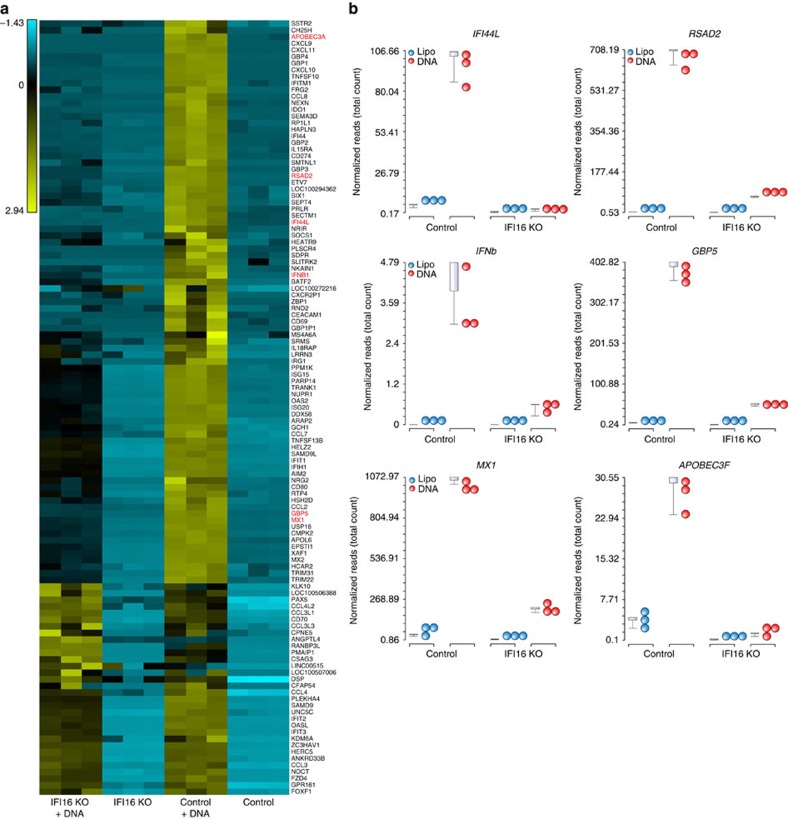
ISG expression profile in IFI16-deficient cells.(a) Control and IFI16 KO cells were stimulated with dsDNA (4 μg ml−1) for 6 h before extracting total RNA and analysing differentially expressed genes on ProtonIon with Partek Gene Specific Analysis Algoritm. (b) Total gene expression (number of reads normalized to total reads) are presented for the 6 red-marked genes: IFI44L, VIPERIN, IFNB1, MX1, APOBEC3F and GBP5. The box represents interquartile range, with the line in the middle representing the median while the whiskers symbolize 90–10% range.